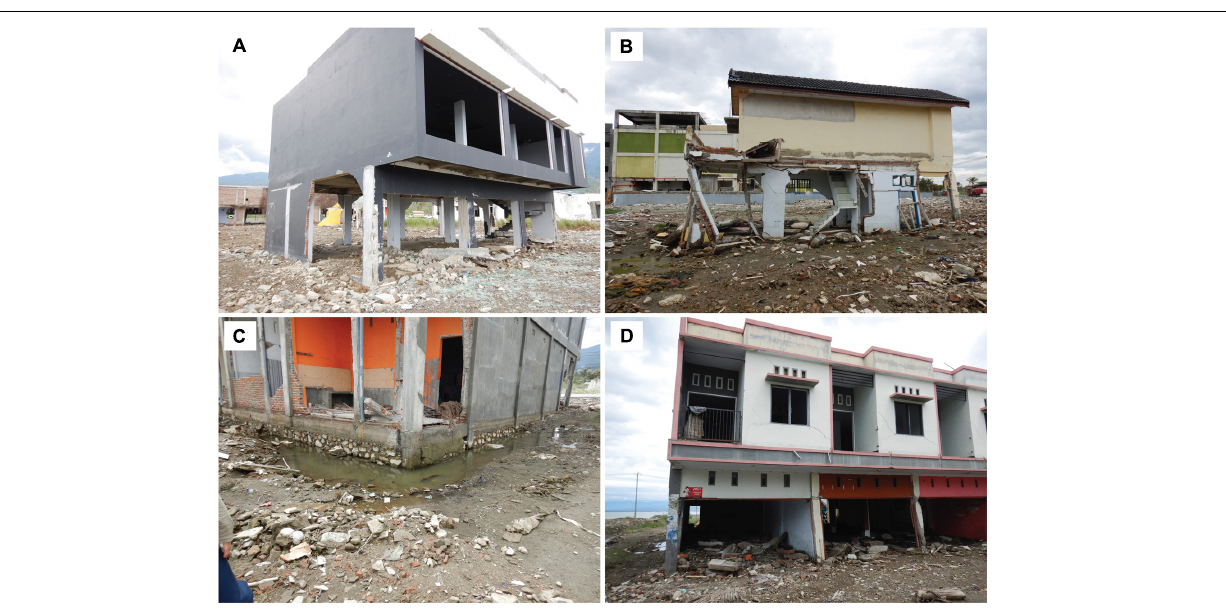
Frontiers in Earth Science |